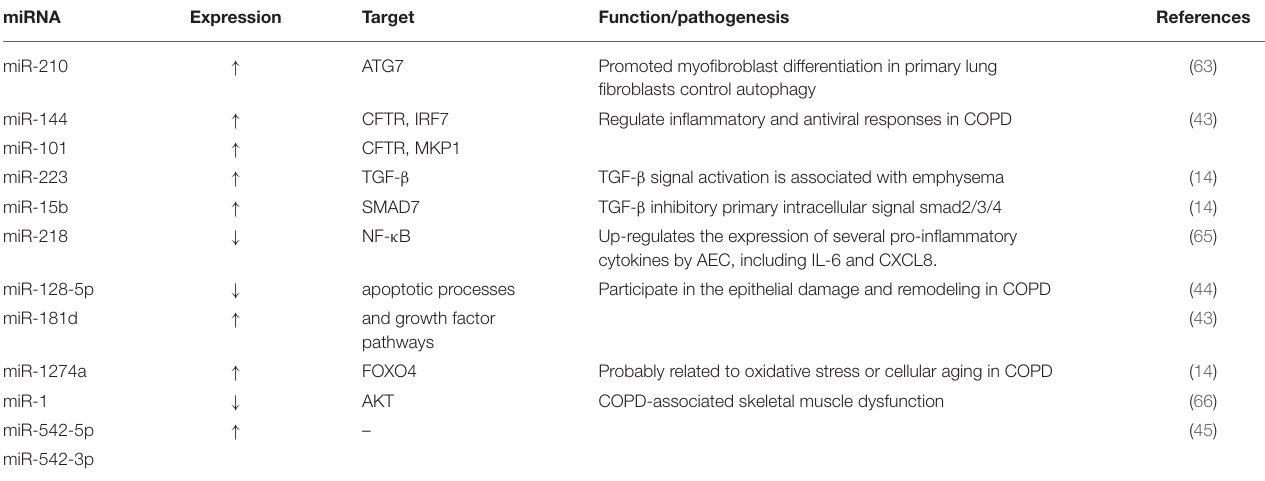
TABLE 2 | List of miRNAs potentially associated with COPD pathogenesis.